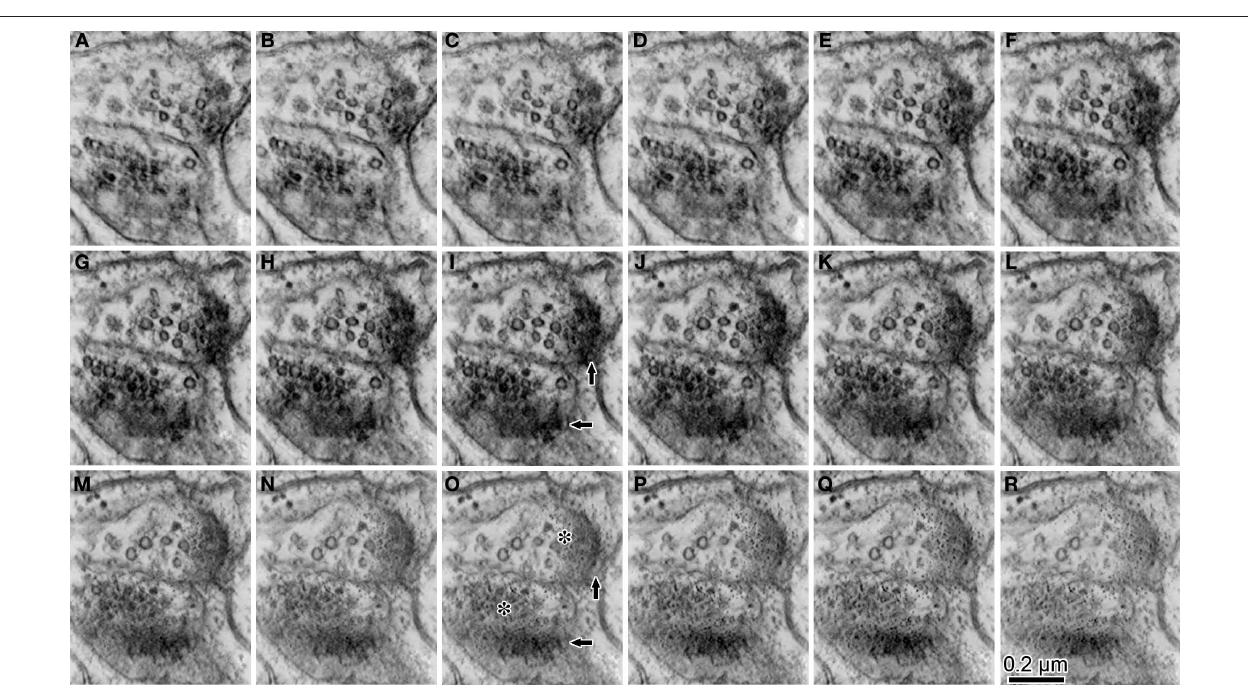
Traces of the PSD gradually emerge at the edge of the presynaptic boutons [for example; arrows in images ( I and O )]. Intermediately electron dense fl occulate substance [for example; asterisks in image ( O )] emerges continuously from the location where most synaptic boutons were found in the previous z-slices. This intermediately dense fl occulate probably corresponds to the synaptic